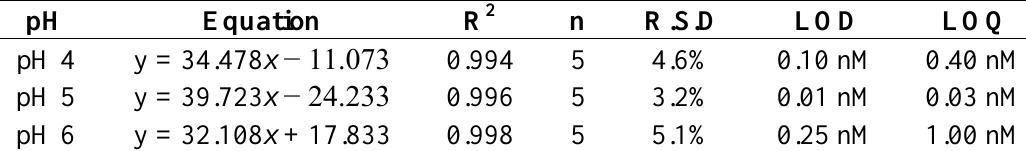
Table 1. Calibration curves of cadmium(II) ions measured at various values of